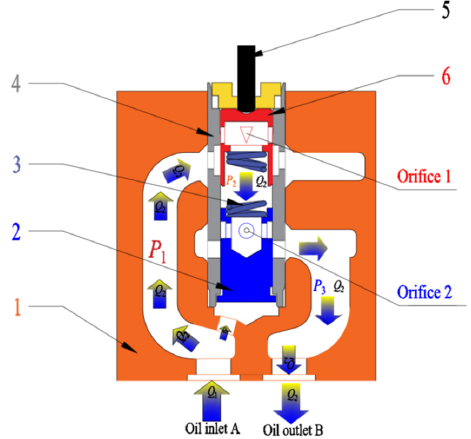
Figure 1. Flow-rate regulation structure diagram of speed-regulating valve. 1—Valve body; 2—pressure compensator; 3—spring; 4—valve sleeve; 5—throttle valve push rod; 6—throttle valve core.